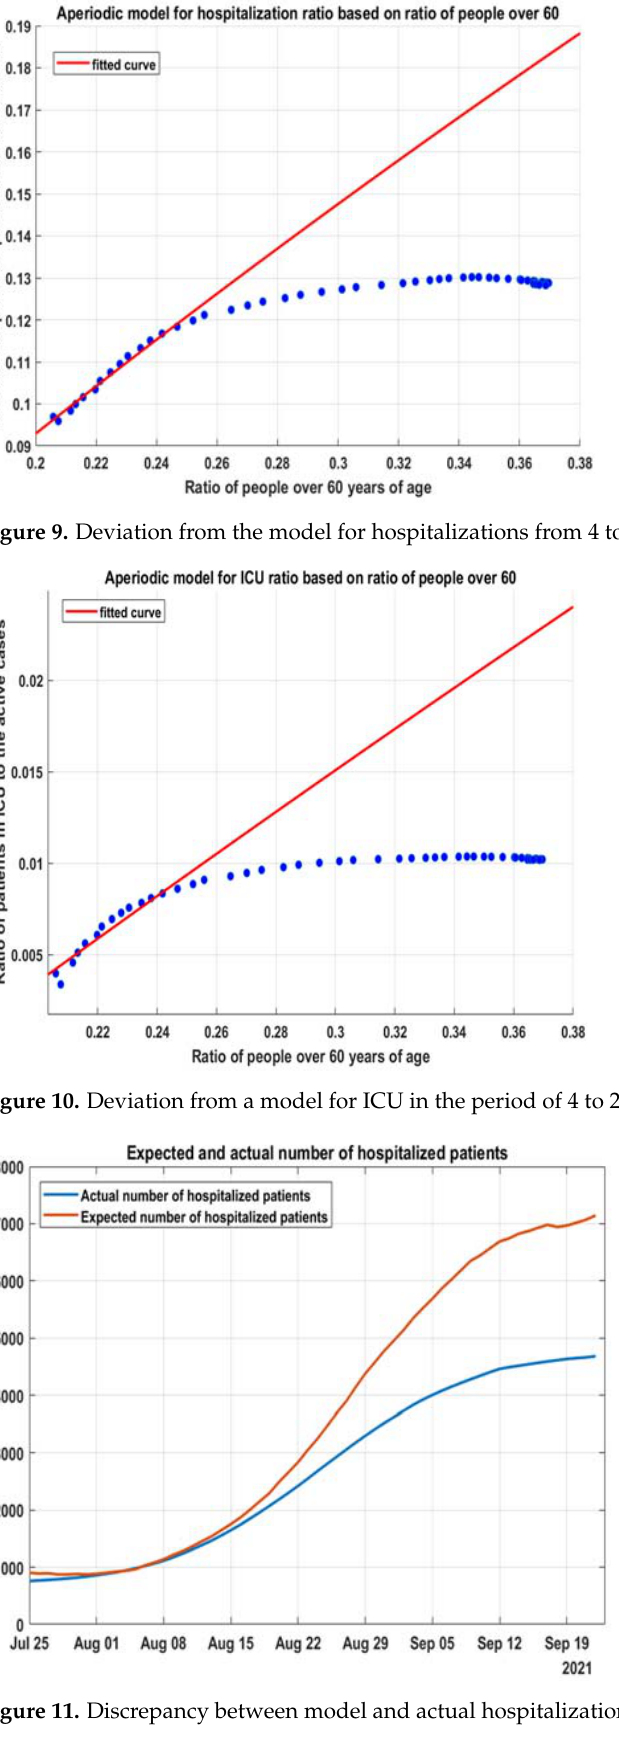
Figure 11. Discrepancy between model and actual hospitalizations.